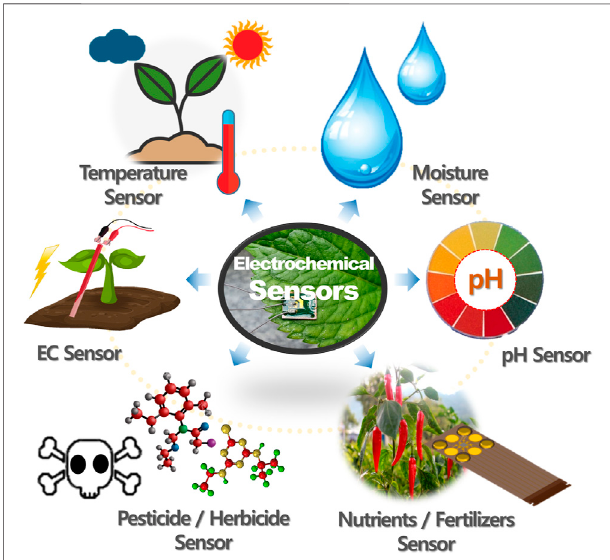
FIGURE 1 | Comparison of physical and chemical sensors for the examination of health in humans and plants.